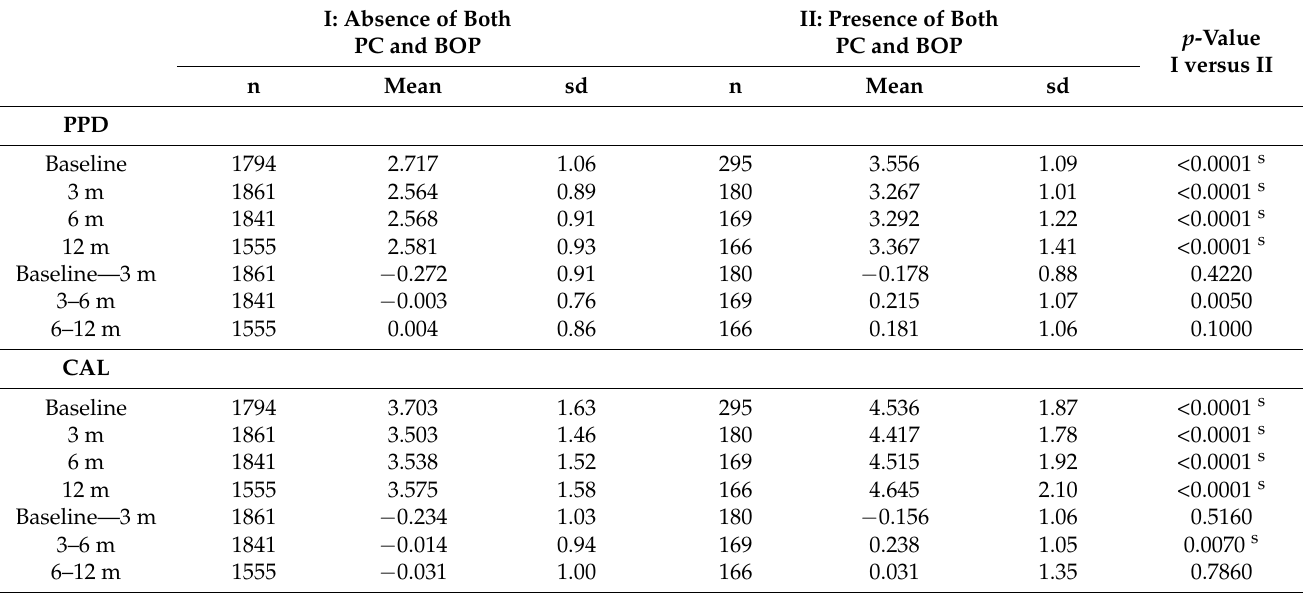
Table 2. Subgroup analysis: number of sites, mean PPD (mm) and CAL (mm) of sites with/without biofilm (PC) and bleeding (BOP) at baseline and after 3, 6 and 12 months.